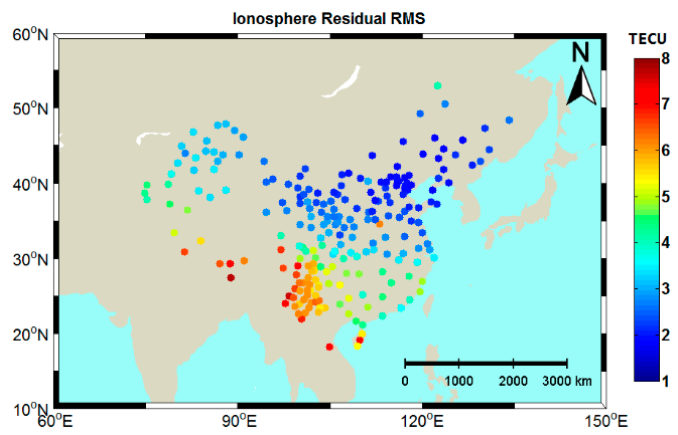
Figure 7. The ionosphere residual RMS in each station (22 January 2016).